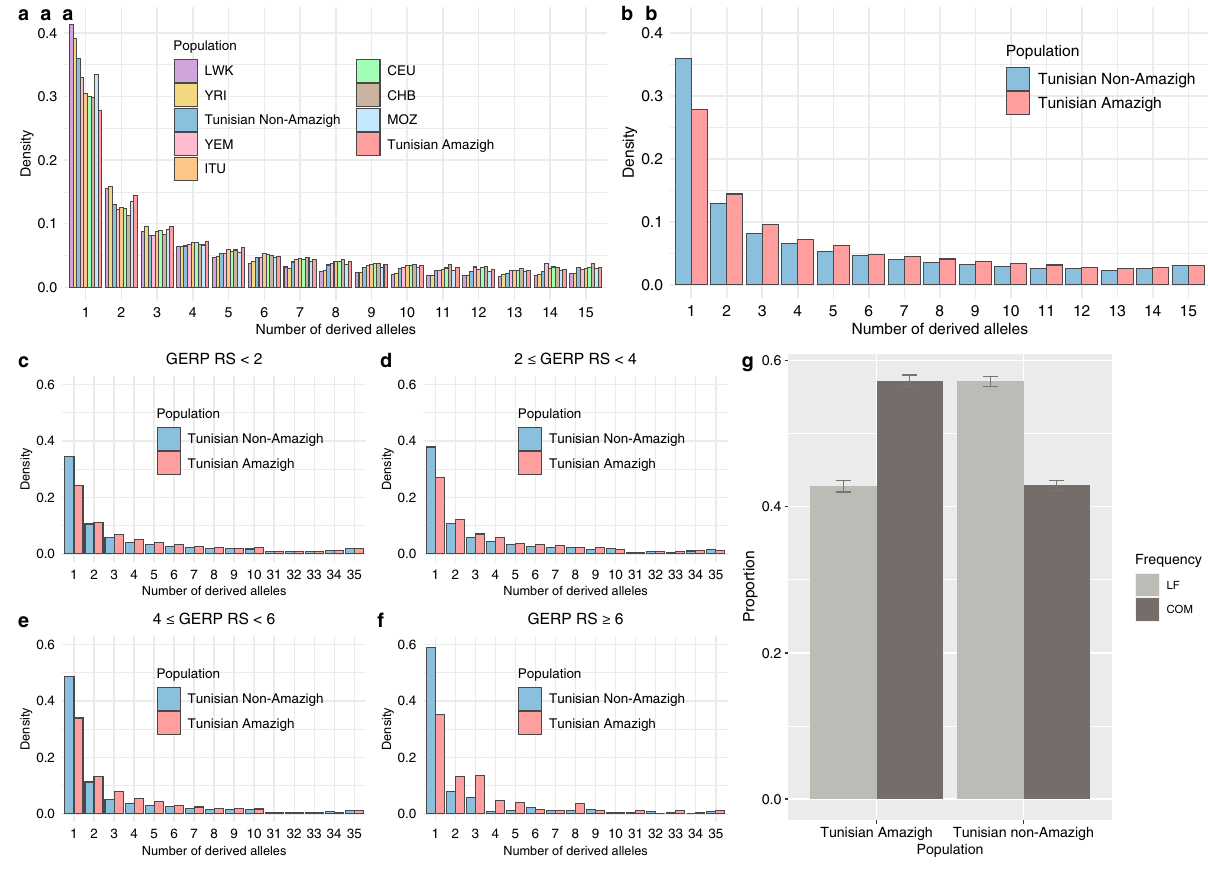
Figure 5. Site frequency spectra of derived alleles and derived allele proportions. Each population was subsampled to 18 individuals, and fixed sites were excluded. For Tunisian Imazighen, the 18 individuals selected were all of the available in our dataset. For Tunisian non-Imazighen, 18 randomly selected individuals were used. ( a ) General site frequency spectrum derived alleles for Tunisian populations, together with a panel of surrounding and other worldwide populations. Population names abbreviated as in Fig. 1. ( b ) General site frequency spectrum of derived alleles for Tunisian populations. ( c – f ) Site frequency spectra of derived alleles in different GERP RS score categories. Plot title indicates the range of GERP RS scores of the variants included. ( g ) Proportion of derive deleterious variants classified by frequency-based categories. Variants included are those with GERP RS scores higher than 2. The frequency-based categories are Low-Frequency (LOW), including singletons and doubletons, and Common (COM), including frequencies higher than tripletons. Error bars represent the 95% confidence